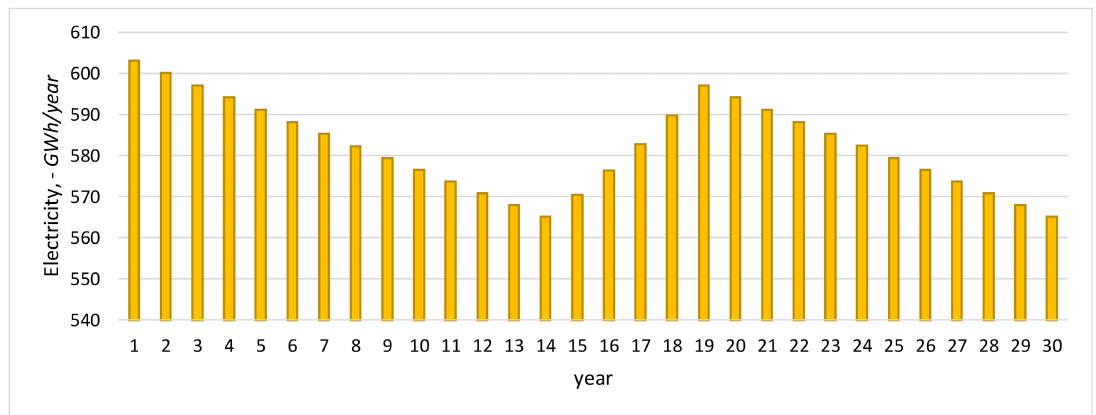
Figure 4. Annual electricity production during the lifetime of the CSP tower plant, a location in Arica and Parinacota region ( − 17.5398865, −